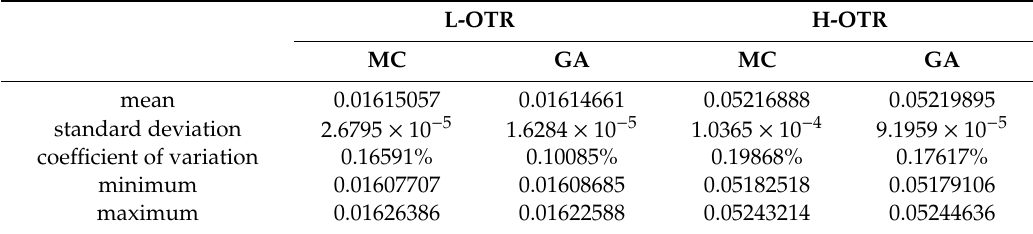
Table 5. Results of the real cooperage simulation, where the OTRs of 50 barrels that were constructed via the proposed methods were analyzed with their mean values, standard deviations, coe ffi cients of variation, and minimum and maximum